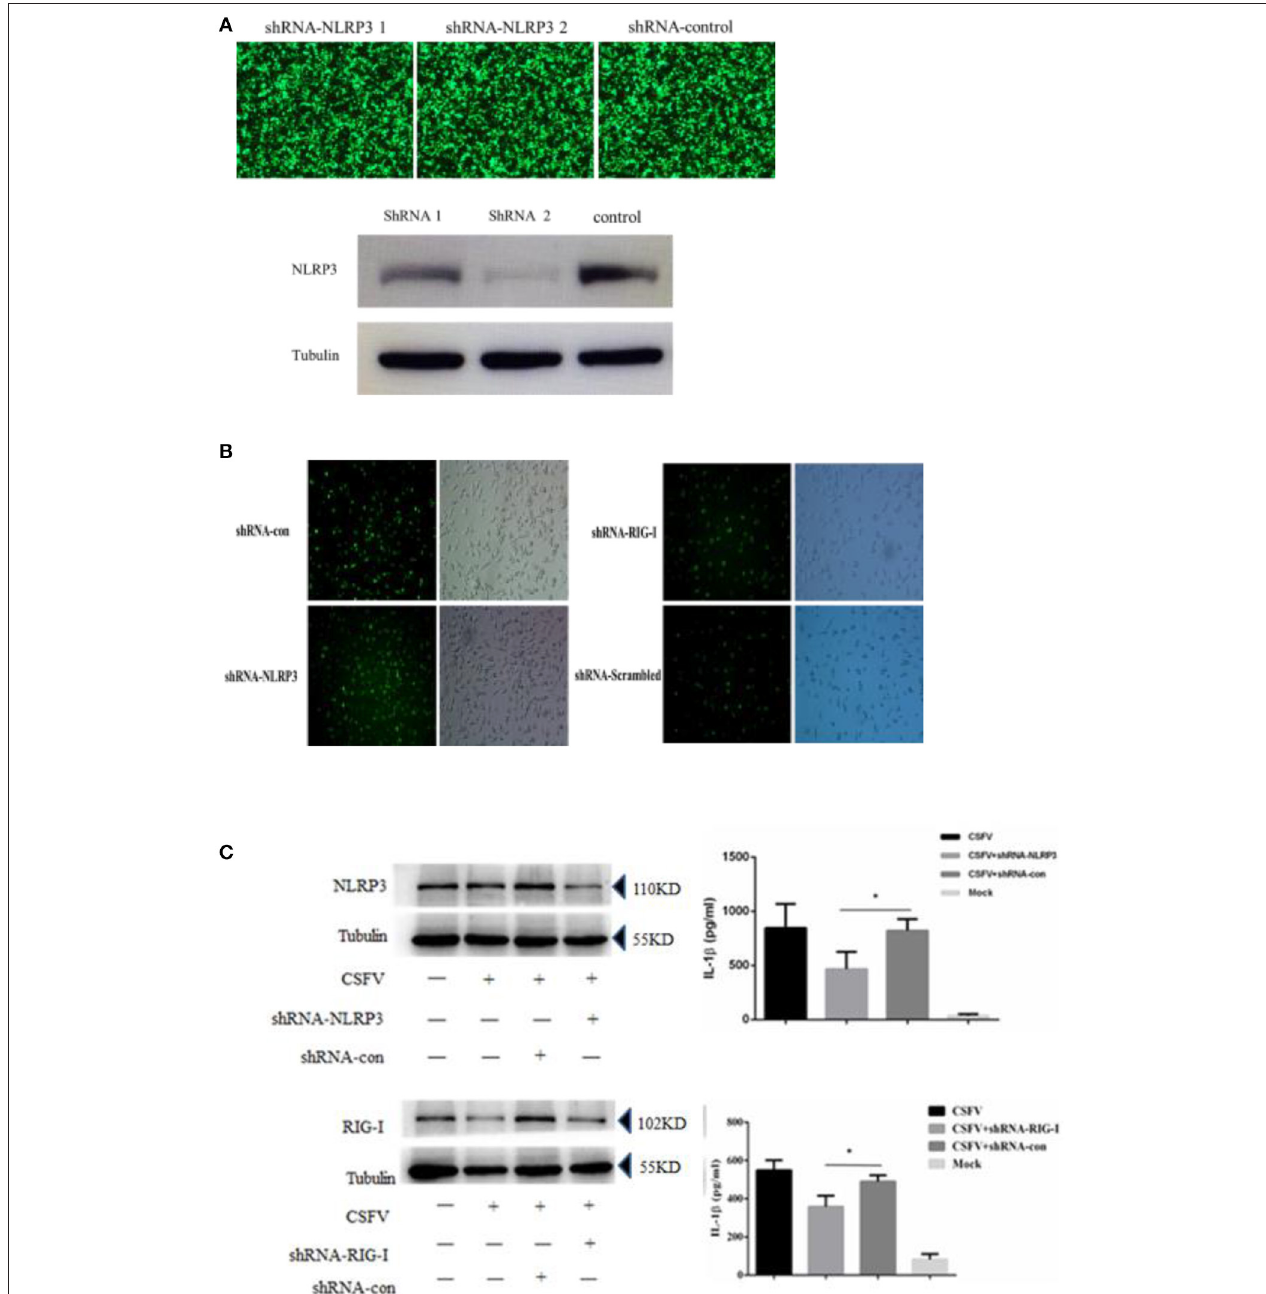
FIGURE 6 | Secretion of IL-1 β in PBMCs induced by CSFV infection depended on the expression of the NLRP3 and RIG-I genes. (A) The NLRP3 interference plasmid was highly efficient at interfering with NLRP3 expression as verified by immunofluorescence and western blotting. The images of immunofluorescence showed no difference in the transfection efficiency of the three plasmids, western blotting showed shRNA 2 had a better interference effect on NLRP3. (B) The rescued lentiviruses LtV-RIG-I, LtV-NLRP3, and LtV-Scrambled were successfully transfected into porcine PBMCs. (C) The secretion of IL-1 β in porcine PBMCs induced by CSFV infection depended on expression of the NLRP3 and RIG-I genes. * P < 0.05. P -values were calculated using an One-way ANOVA